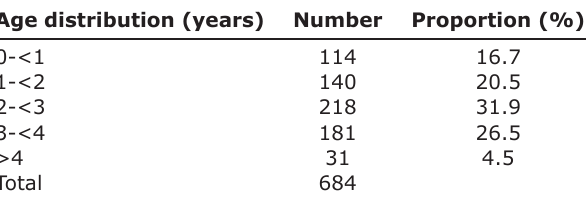
Table-2: Age distribution of female goats slaughtered at Nsukka slaughterhouse. Age distribution